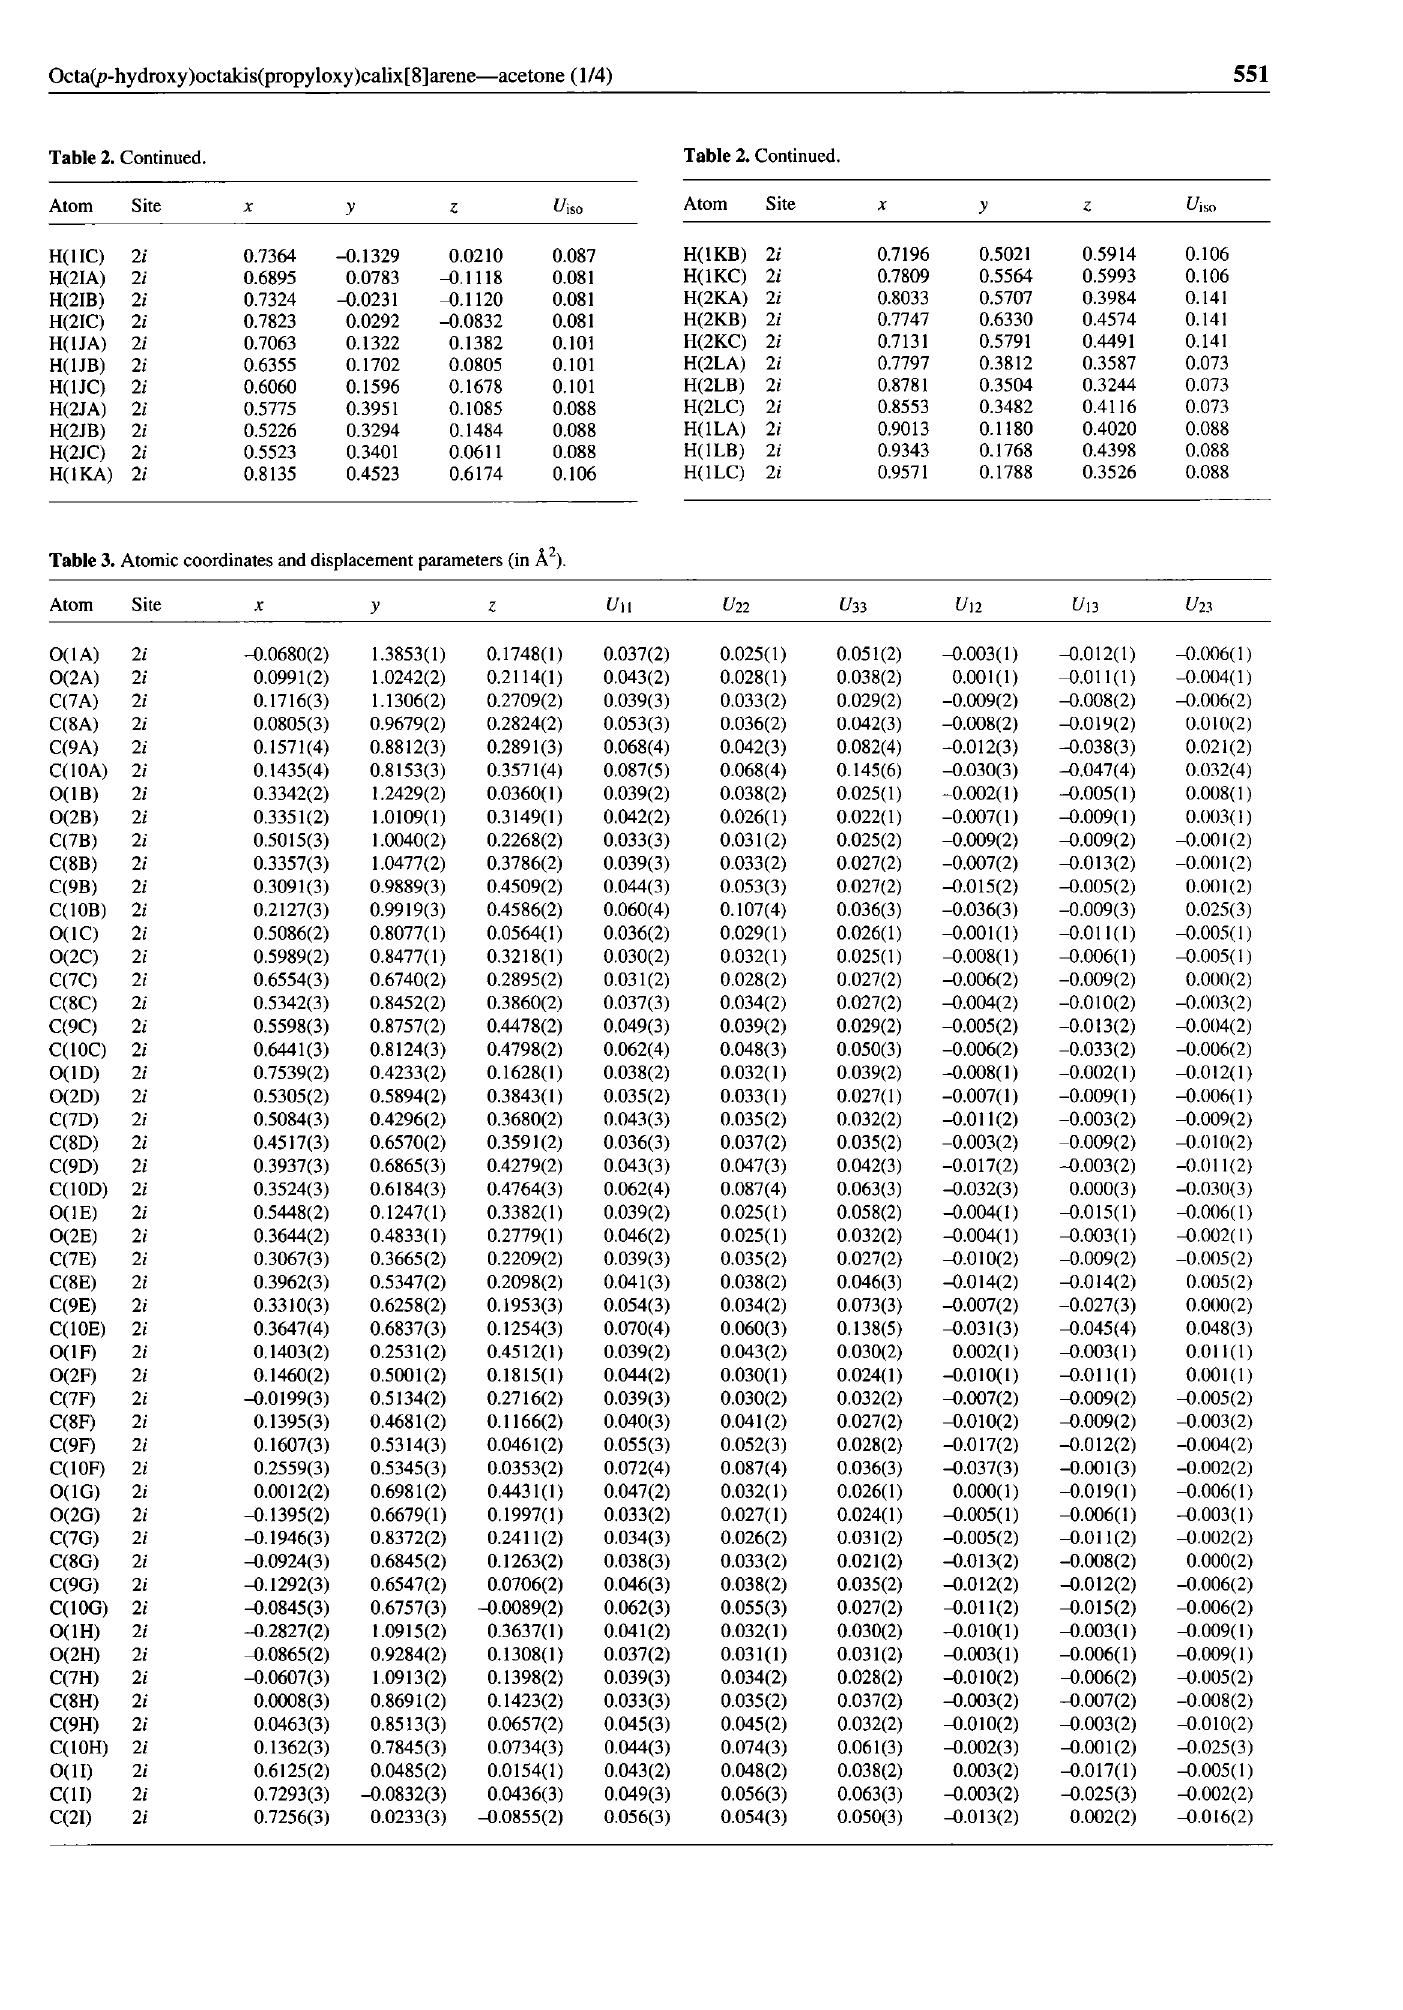
Table 3. Atomic coordinates and displacement parameters (in Ä 2